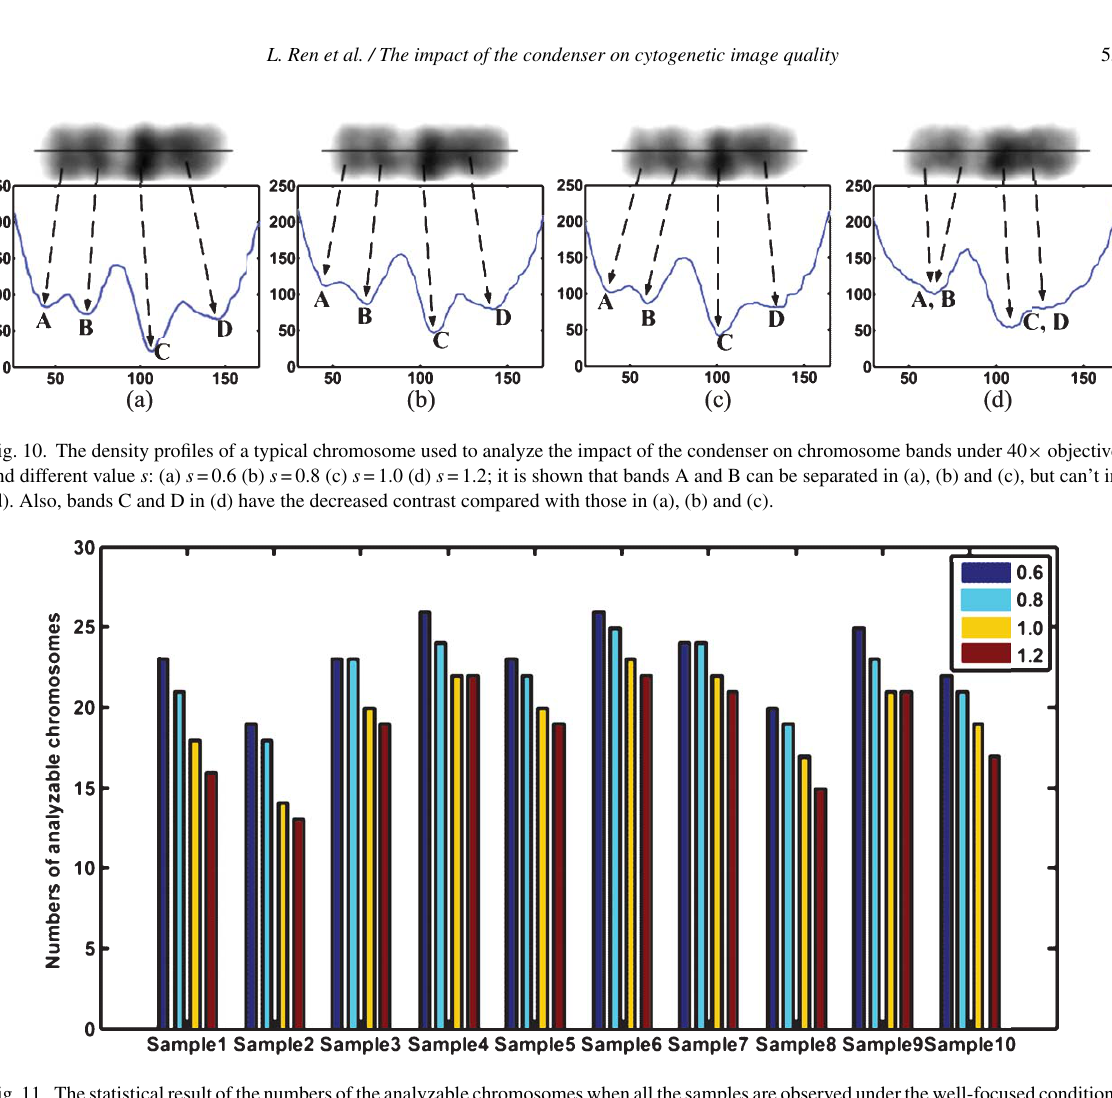
Fig.11. Thestatisticalresultofthenumbersoftheanalyzablechromosomeswhenallthesamplesareobservedunderthewell-focusedcondition; for each sample, four bars from left to right represent the number of analyzable chromosomes under well-focused condition of s =0.6, 0.8, 1.0 and 1.2,